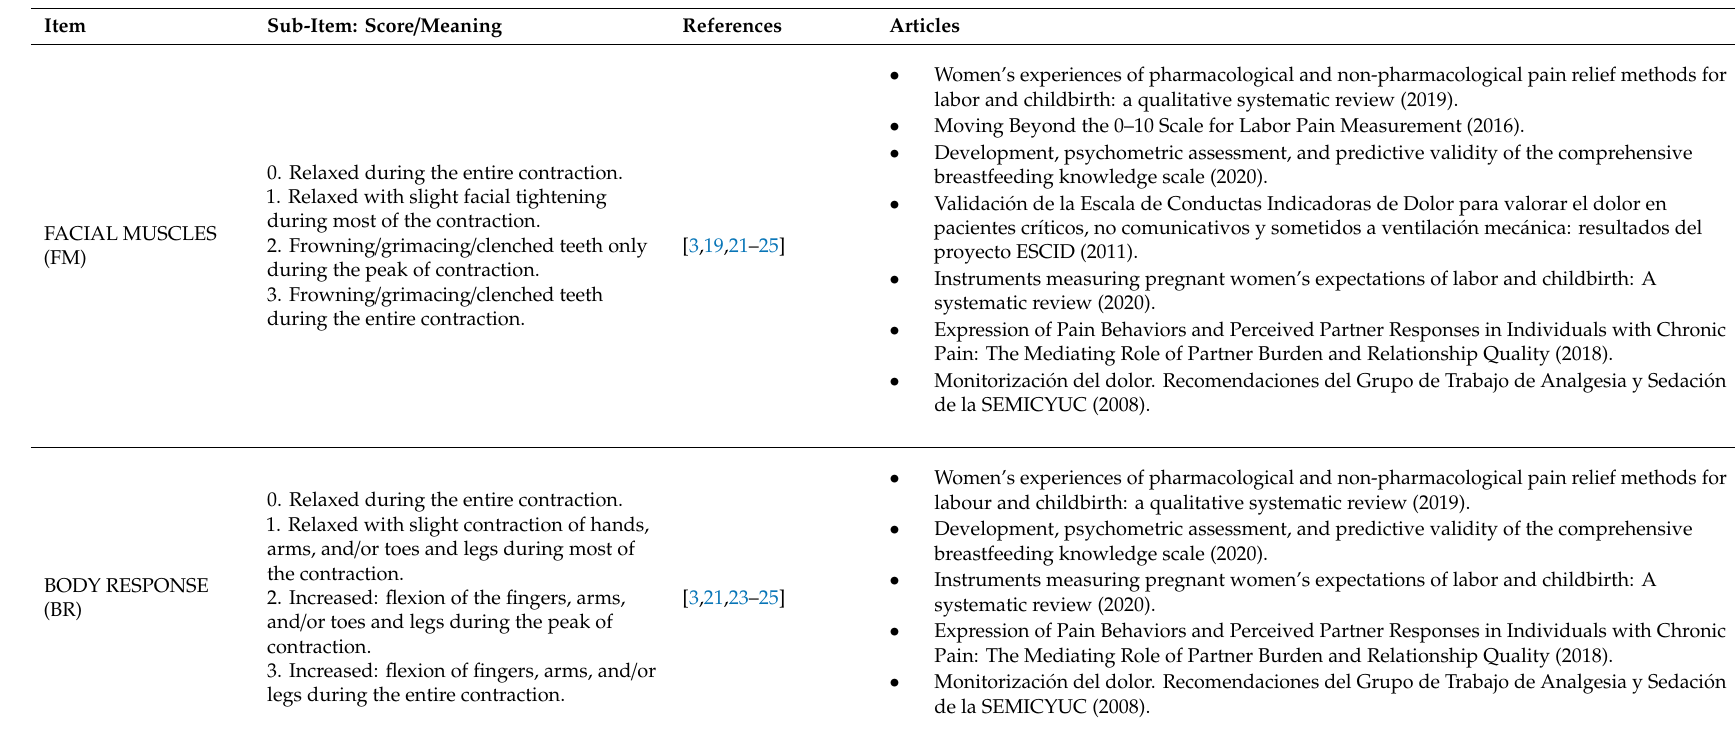
Table 1. Scientific literature used for the preparation and adaptation of ESVADOPA (in Spanish, Escala de Valoraci ó n de la Expresi ó n del Dolor durante el Trabajo de Parto ).